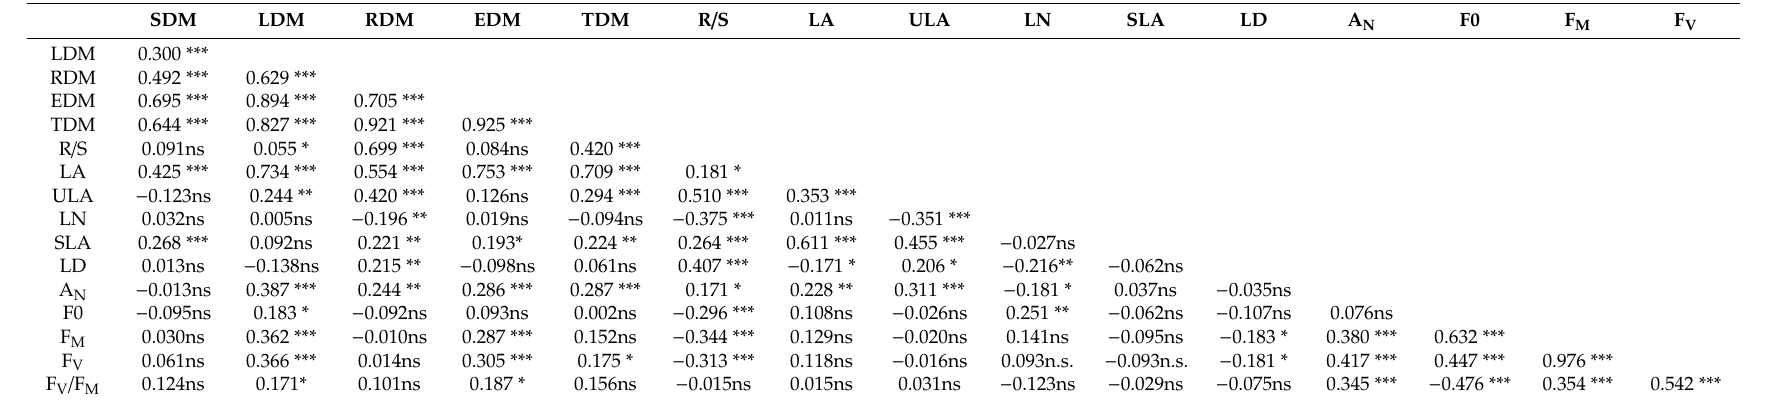
Table 3. Relationship between morphological and physiological parameters of ornamental shrubs under salt stress